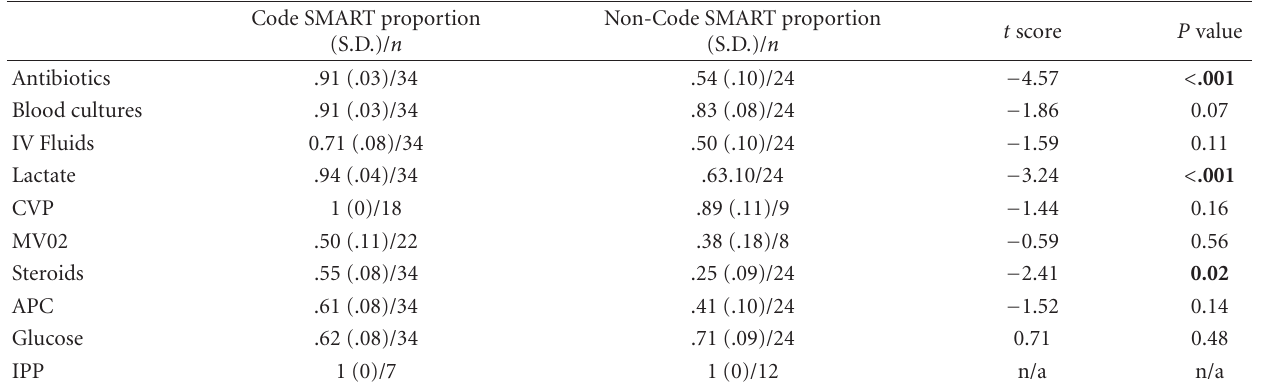
Table 3: Compliance with individual sepsis tasks.